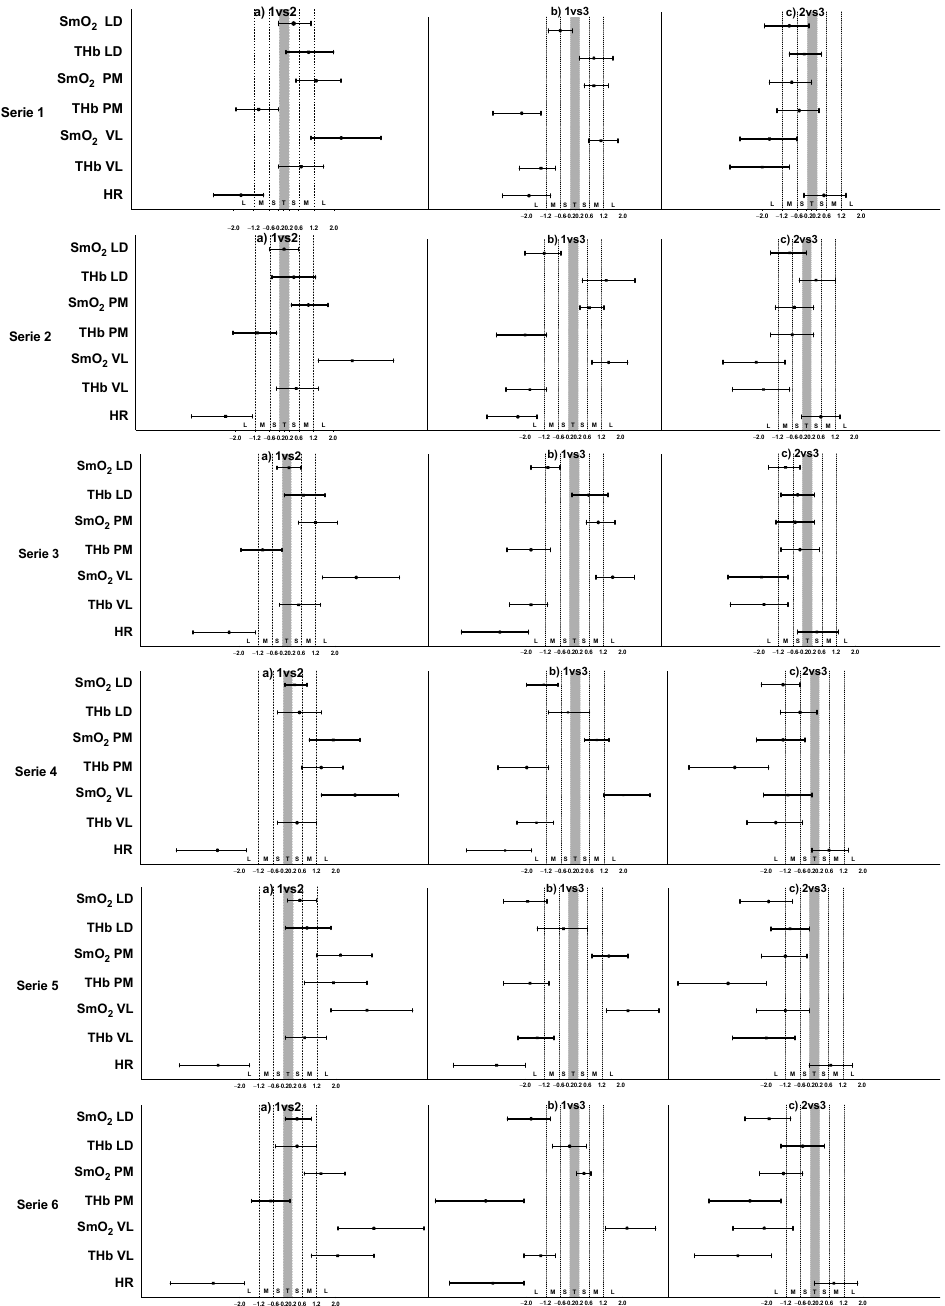
Figure 2. Standardized (Cohen) differences in the considered variables during exercise bouts. Error bars indicate uncertainty in the true mean changes with 95% confidence intervals. Abbreviations: 1—RT protocol 1; 3—IT protocol 2; SIT protocol 3; SmO 2 —muscle oxygen saturation; tHb—total hemoglobin; LD—latissimus dorsi; PM—pectoralis major; VL—vastus lateralis; HR—heart rate; T—trivial effect; S—small effect; M—moderate effect; L—large effect.